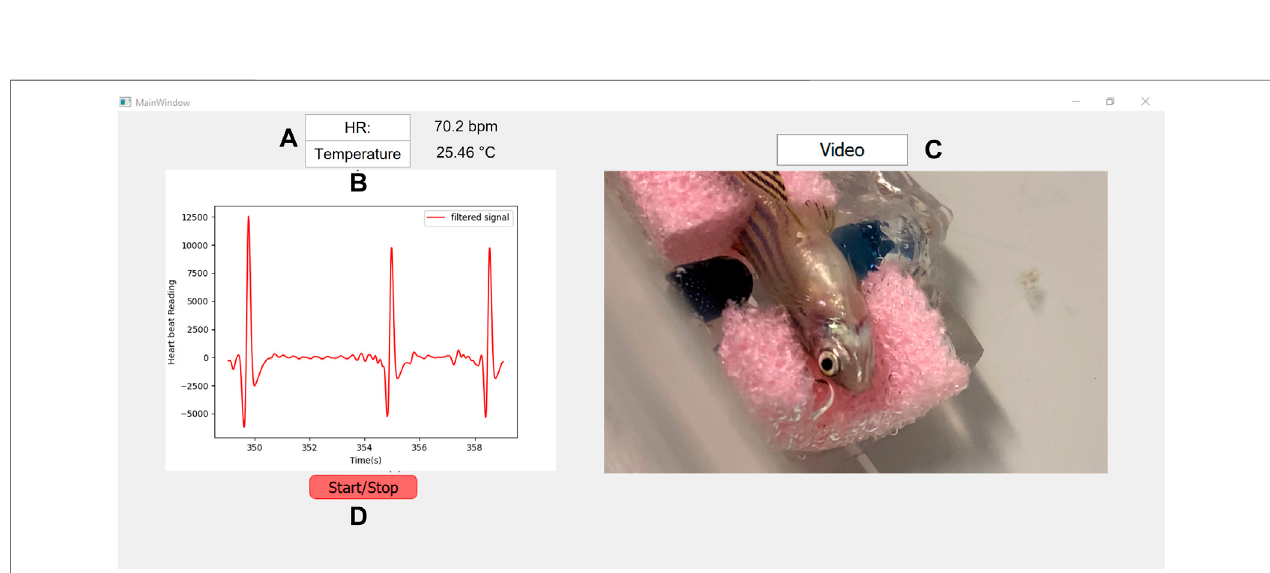
FIGURE 7 | Graphical interface developed, during the signal acquisition.